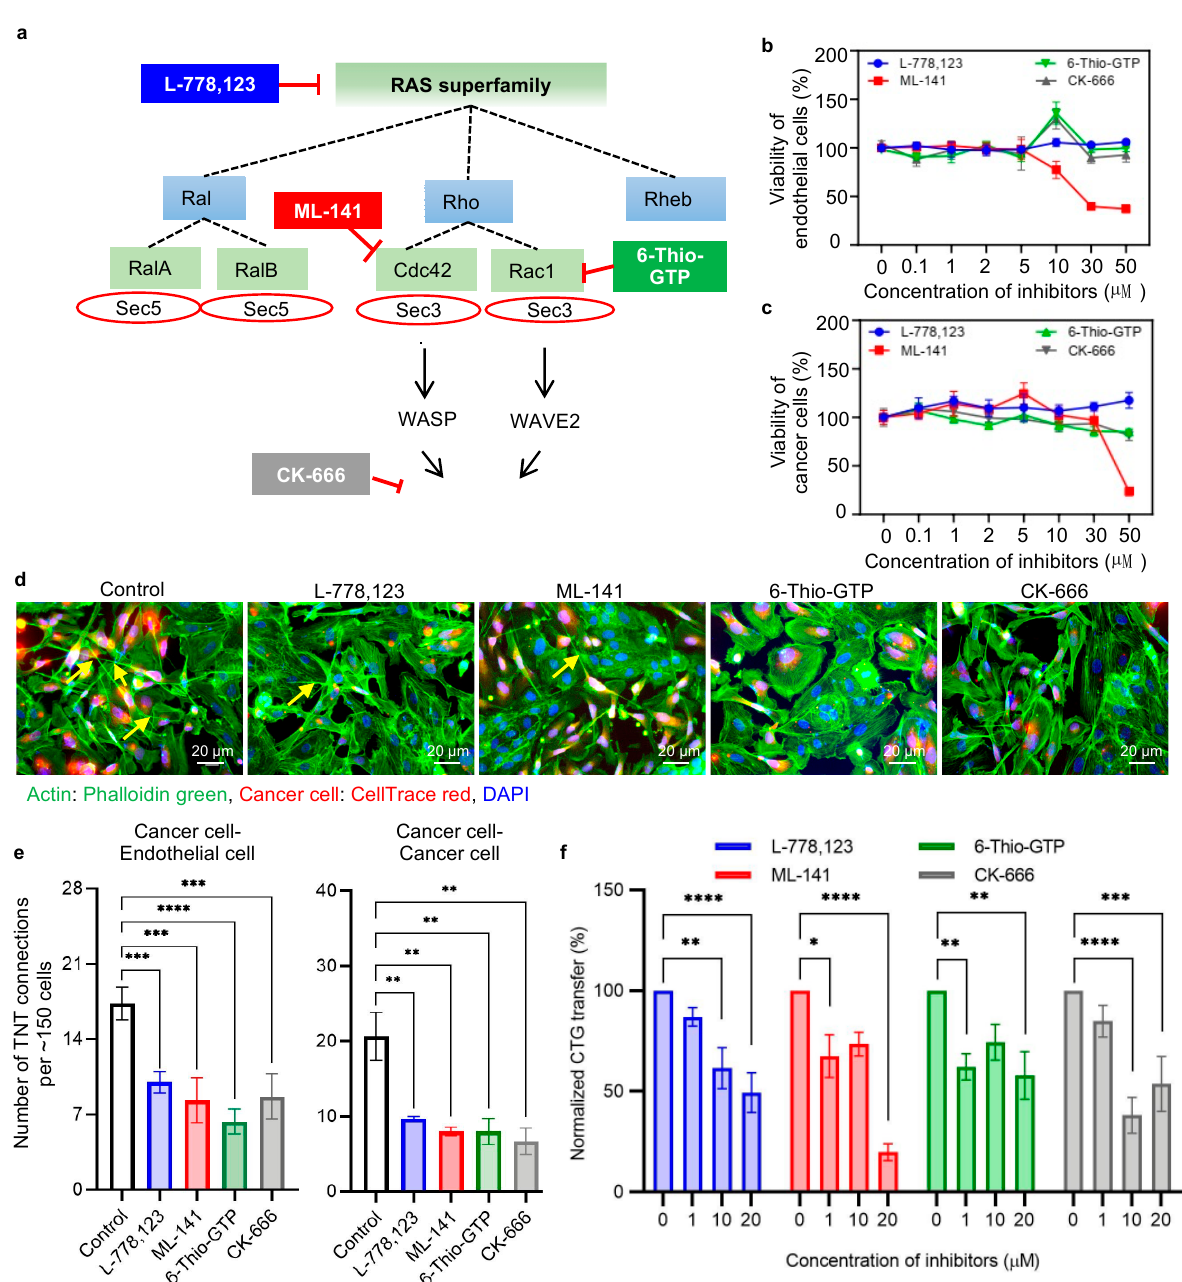
Figure 3. Effect of RAS GTPase inhibitors on TNT formation and CFSE transfer. ( a ) Schematic representation of the signaling cascade of the small Ras family GTPases and exocyst proteins involved in actin polymerization. Specific inhibitors were selected to downregulate proteins in different stages of the signaling pathway. A geranylgeranyltransferase-1 inhibitor, L-778,123, potentially inhibits K-Ras prenylation, ML-141 inhibits activation of Cdc42 GTPase, 6-Thio-GTP inhibits Rac1 GTPase activation, and CK-666 blocks the dimerization of Arp2 and Arp3, which is involved in the formation of new actin filaments. ( b ) Cell viability of endothelial cells in the presence of inhibitors. Cells were treated with different concentrations of inhibitors 0.1–50 µM for 24 h, and the cell viability was measured by MTT assay. The only significant reduction in cell viability was observed at 30 µM and 50 µM concentrations of ML-141 in case of endothelial cells. ( c ) Similarly, cancer cell viability was checked in the presence of inhibitors. Only a concentration of 50 µM of ML-141 was found to be toxic in cancer cells. ( d ) Representative fluorescence microscopy images show the effect of inhibitors in nanoscale communication between cancer cells and endothelial cells. Cancer cells (MDA-MB-231) were loaded with CellTrace red and co-cultured with preformed endothelium in 3D tumor matrix, in the presence and absence of inhibitors. Each inhibitor (L-778,123, ML-141 and 6-Thio-GTP) was used separately at a concentration of 10 µM (except 40 µM for CK-666). The co-culture was stained with phalloidin green to visualize the nanotubes. A visible difference in the number of nanoscale communications was observed in the presence of inhibitors. ( e ) Graph representing the quantification of the number of heterotypic (cancer cell–endothelial cell) and homotypic (cancer cell–cancer cell) nanoscale